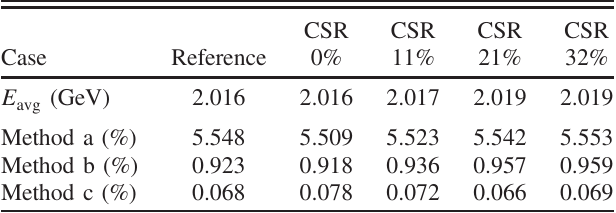
TABLE VIII. Average energy ( E ) and RMS energy spread of avg the electron beam after propagation through 5 m plasma source. Methods a, b, and c are the cases where the RMS energy spreads obtained by (a) considering total electron beam particles, (b) con- sidering effective region (shaded area in the third row of Fig. 24), and (c) using Gaussian fitting over the effective